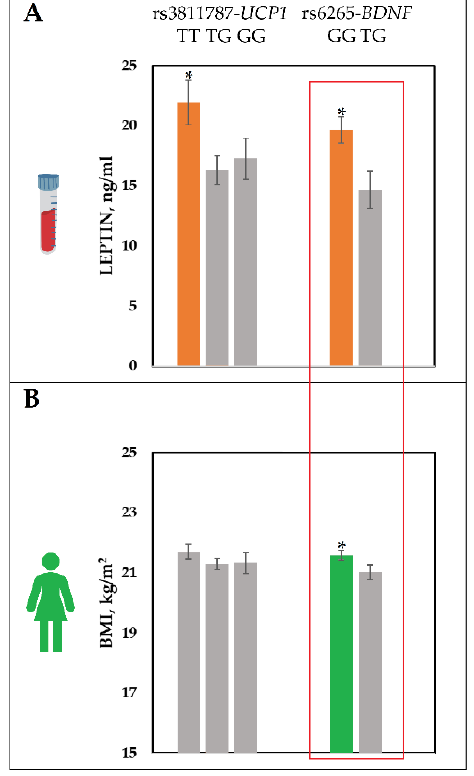
Figure 2. The leptin levels and BMI divided by the rs3811787 ( UCP1 ) and the rs6265 ( BDNF ) genotypes. ( A ) Comparison of leptin levels by the rs3811787 ( UCP1 ) and rs6265 ( BDNF ) genotypes for the group of females with normal BMI ( n = 215). ( B ) Comparison of BMI by the rs3811787 ( UCP1 ) and rs6265 ( BDNF ) genotypes for the group of females with normal BMI ( n = 215). The data shown are mean ± SE. * p ≤ 0.05.